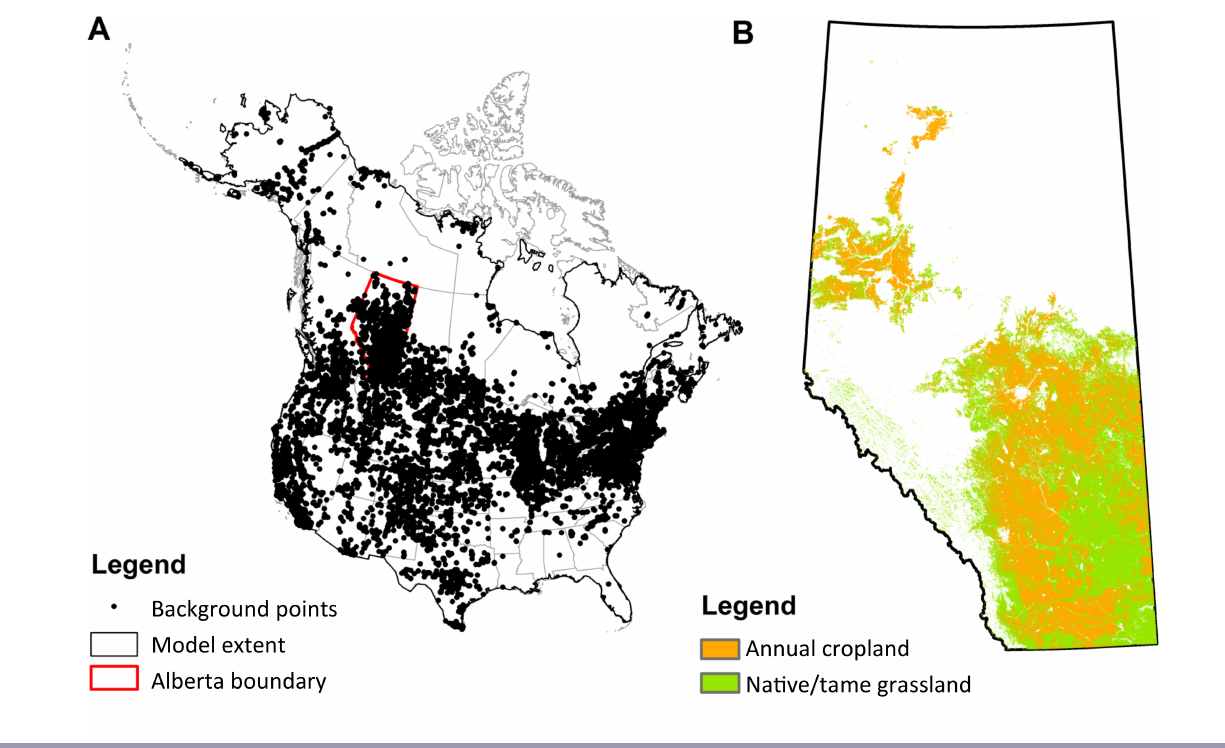
Fig. 1 . (A) Model extent and distribution of background points used to model climate suitability for grassland songbirds in North America. (B) Distribution of crop and native/tame grassland and hayland cover in Alberta (Agriculture and Agri-Food Canada